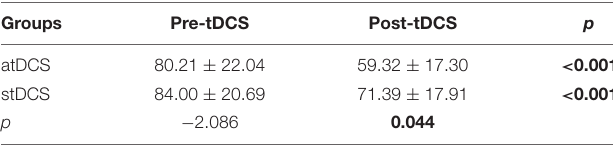
TABLE 2 | Statistical analysis of the treatment items received by the two groups. Groups b + s1 b + s2